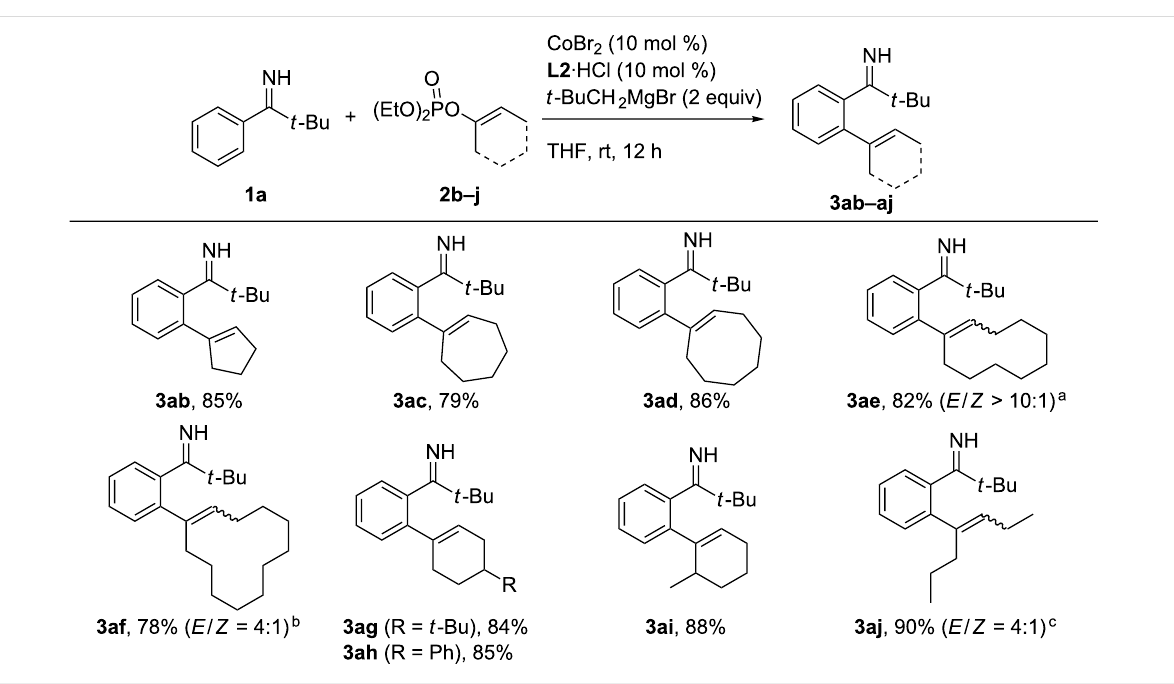
Scheme 3: Reaction of 1a with various alkenyl phosphates. a A mixture of E - and Z -alkenyl phosphate (ca. 1:1) was used. b Z -rich alkenyl phosphate ( Z / E = ca. 9:1) was used. c E -alkenyl phosphate was